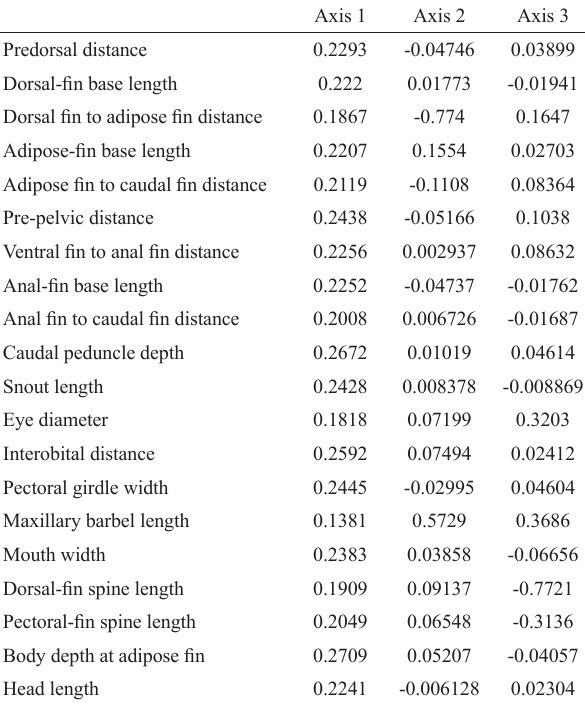
Table 5. Principal Component loadings between R. branneri , R. voulezi and Rhamdia cf